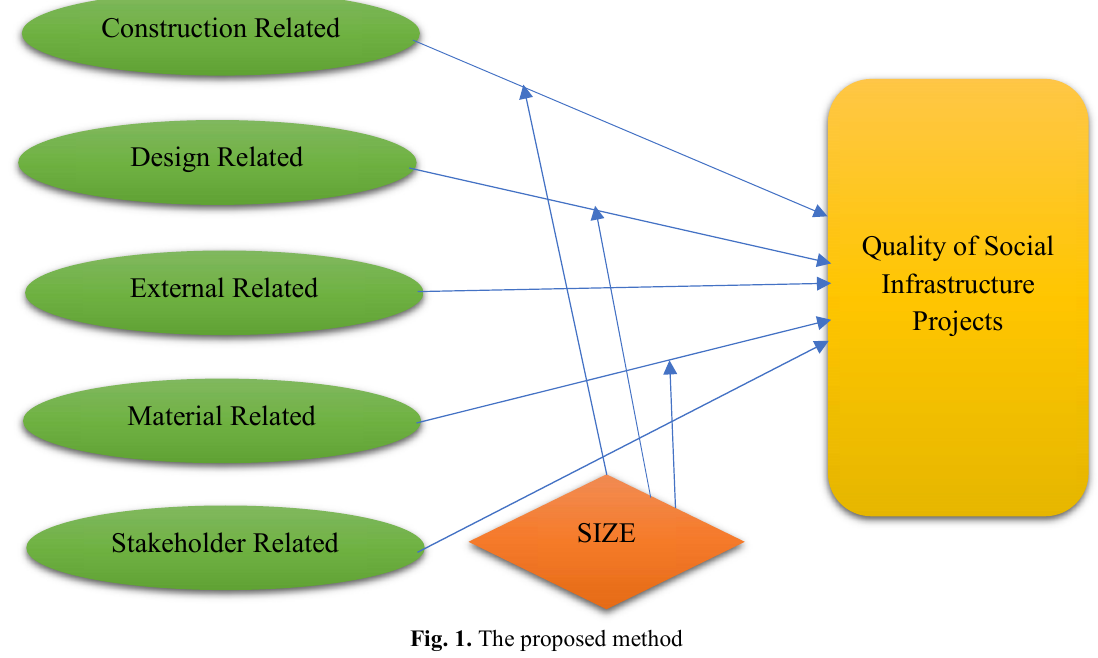
Fig. 1. The proposed